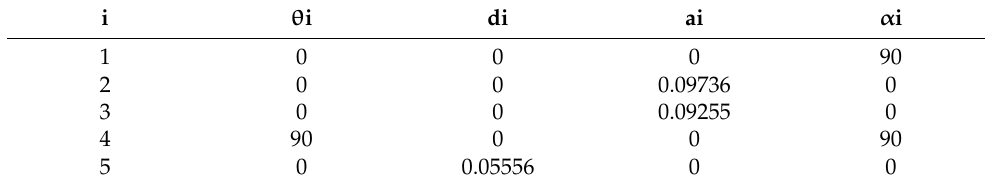
Table 1. DH parameter list.